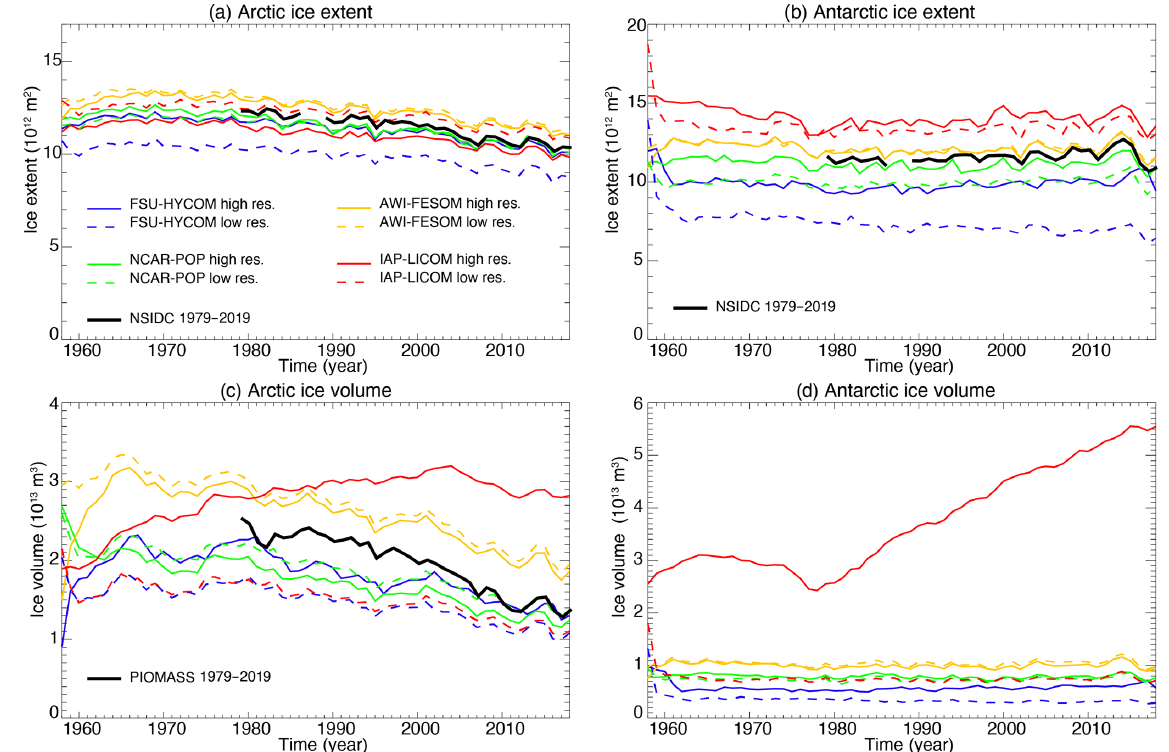
Figure 14. Modeled time evolution of annual mean Arctic and Antarctic (a, b) sea ice extent (10 12 m 2 ) and (c, d) sea ice volume (10 13 m 3 ). The black lines are observations from the National Snow and Ice Data Center (NSIDC) and results the from Pan-Arctic Ice Ocean Modeling and Assimilation System (PIOMAS) (Schweiger et al.,